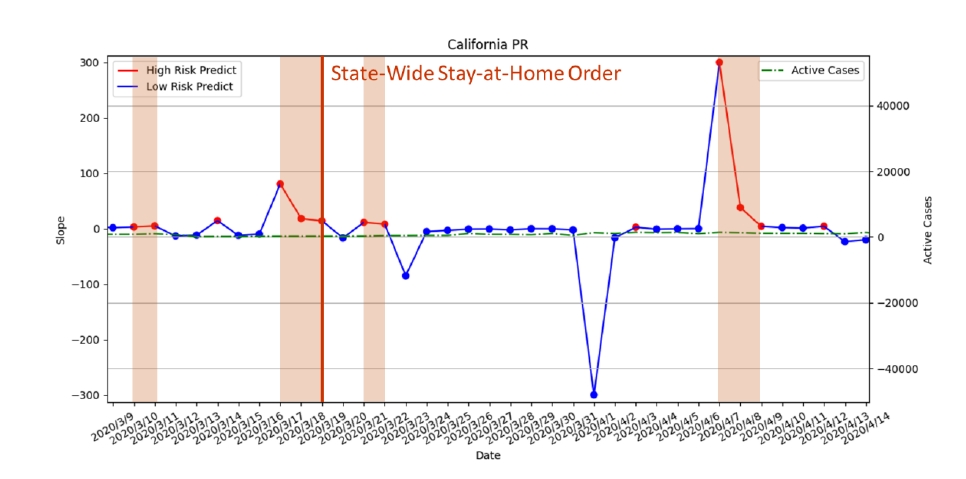
Figure 15. The result of risk analysis with PR for statewide stay-at-home orders in California.